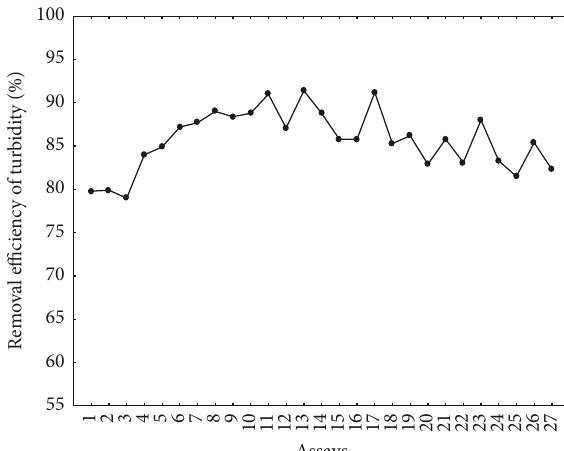
Figure 3: Removal efficiency of M. oleifera and aluminium sulphate for compounds with UV 254nm